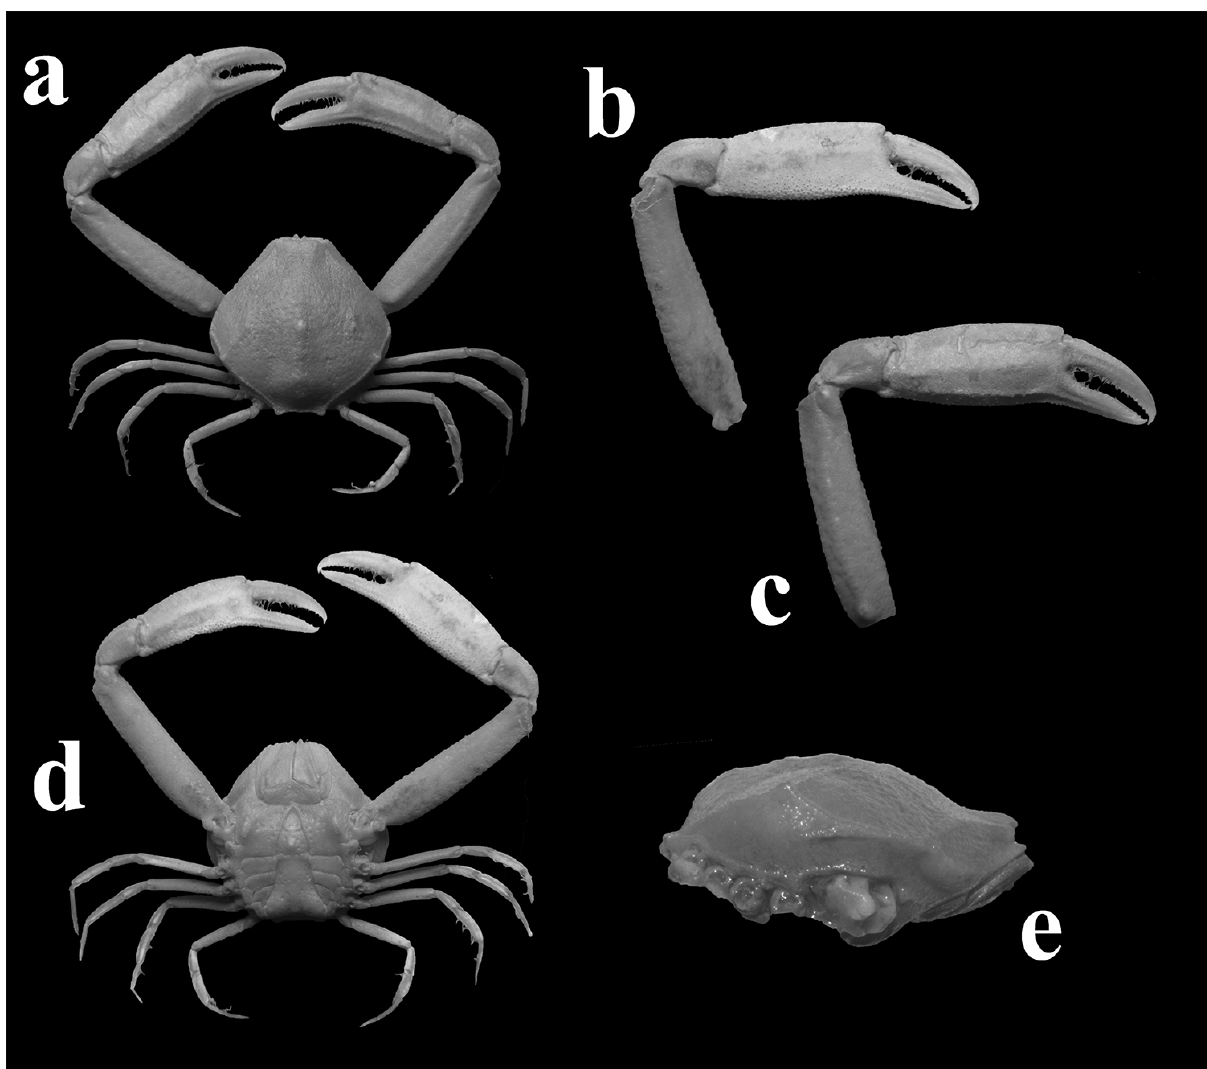
Figure 4. Bellayra persicum gen. nov., sp. nov., holotype, male (CL 7.88 mm, CB 7.83 mm) (ZSI-896/10). a , Habitus, dorsal view; b , right cheliped, outer view; c , right cheliped, inner view; d , carapace, ventral view; e , carapace, lateral